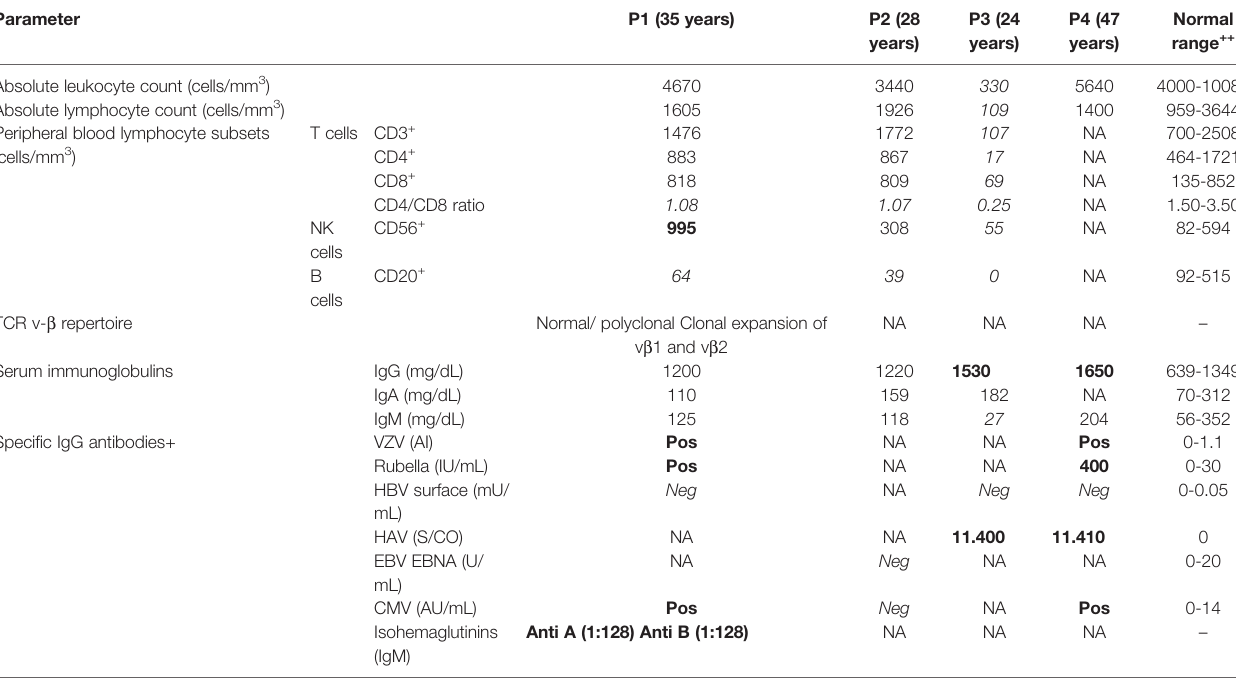
NA, Data is not available; NK, Natural killer cells; TCR, T-cell Receptor; TREC, T-cell receptor excision circles; PHA, Phytohemagglutinin; HC, Healthy Control; Ig, Immunoglobulin; VZV, Varicella Zoster virus; HBV, Hepatitis B virus; HAV, Hepatitis A virus; EBV, Epstein-Barr virus; EBNA, Epstein-Barr nuclear antigen; CMV, Cytomegalovirus; Pos, Positive; Neg, Negative. +Numerical values are presented when available. ++ Reference range for adult lymphocyte subsets were taken from Apoil et al. (15). Values in bold in italics are above and below reference range, respectively.